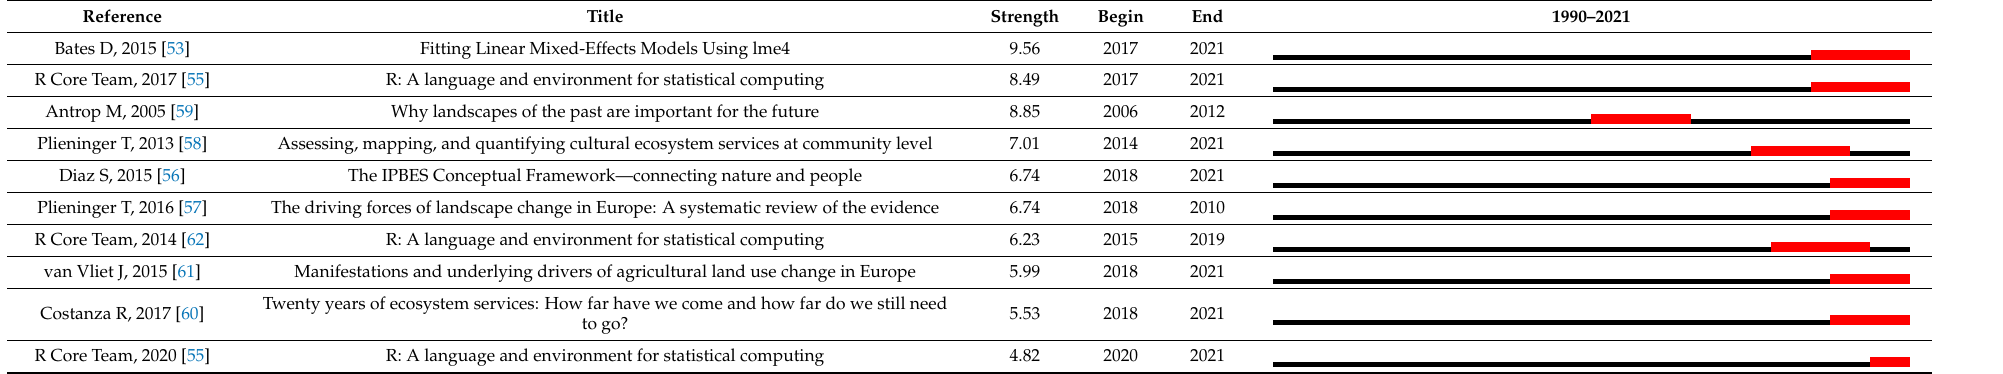
Table 3. Top 10 references with the strongest citation bursts from 1990 to